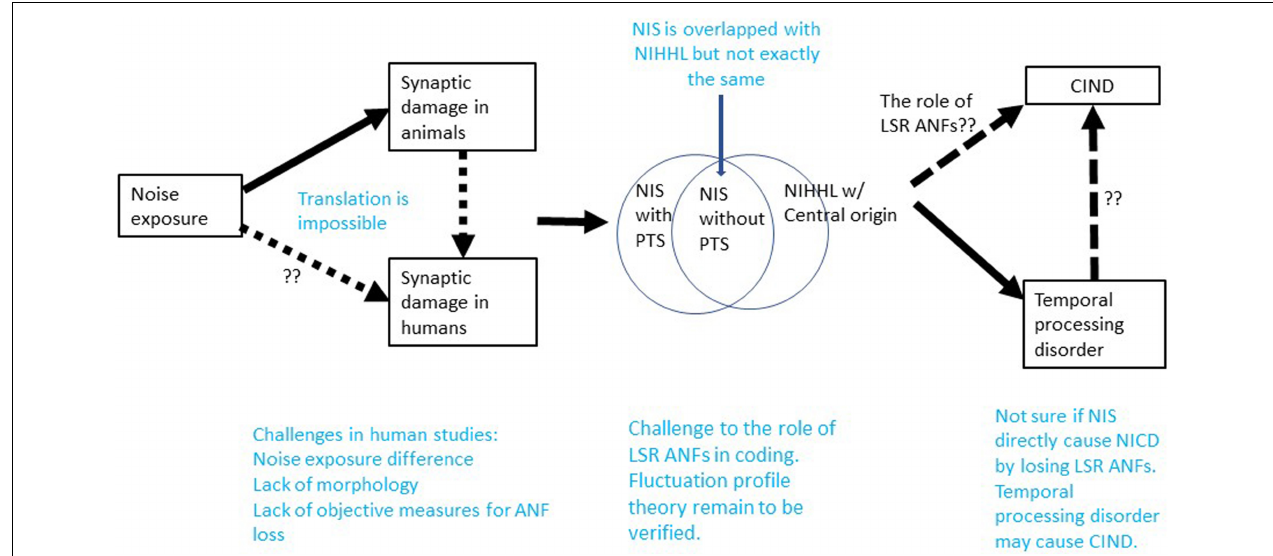
FIGURE 3 | Summary on what we know and what we do not know in the research of NIS and NIHHL. Note that NIS without PTS is overlapped with NIHHL of peripheral origin. The dashed lines without question markers indicate where the connection remain to be speculation and need to be verified.